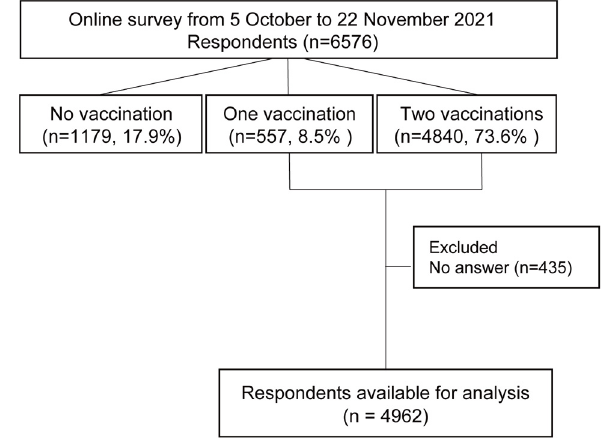
Figure 1. Flow diagram of the present study.